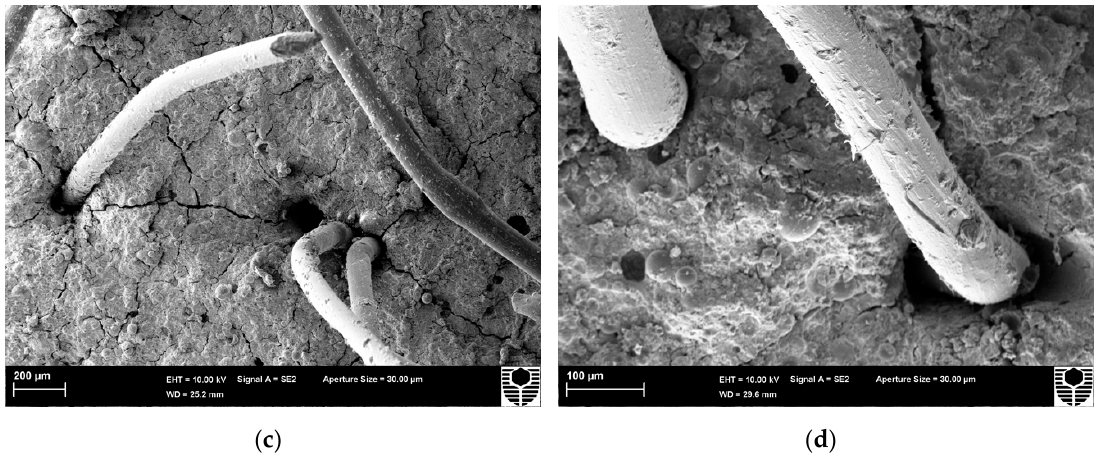
Figure 8. SEM micrograph showing the microstructure of fractured surface of ( a ) PVA-FRGC-1, ( b ) PVA-FRGC-2, ( c ) PVA-FRGC-3 and ( d ) close-up of PVA-FRGC-1.